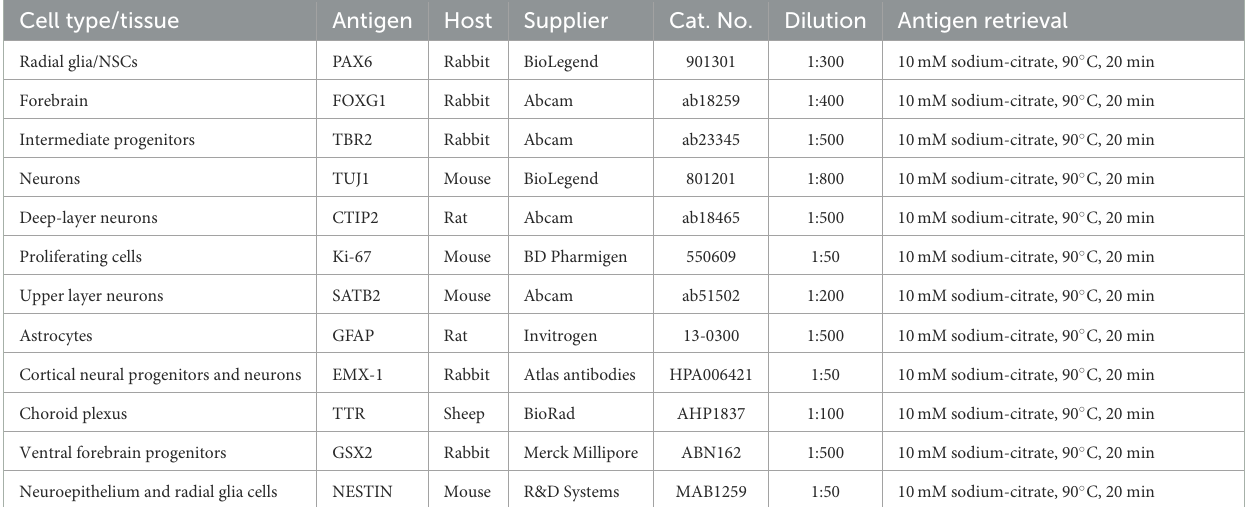
TABLE 2 Primary antibodies for cortical organoid characterization.